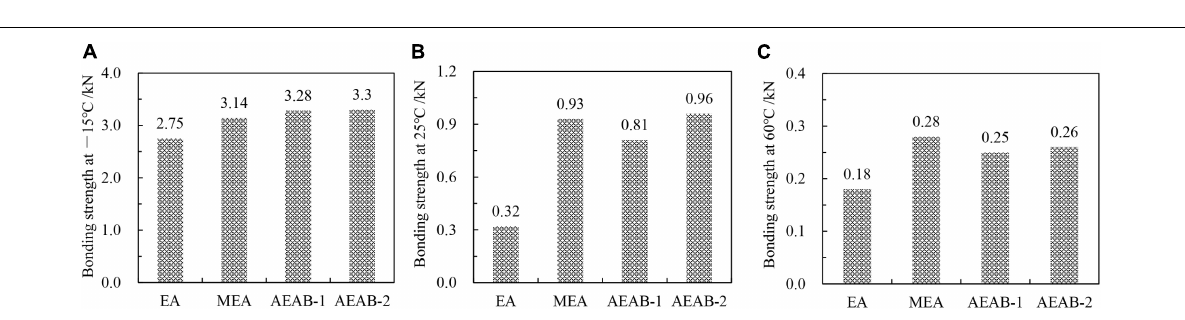
FIGURE 10 | Bonding strength of different coating materials at different temperature: (A) At − 15 ◦ C (B) At 25 ◦ C (C) At 60 ◦ C. In the figures, EA represents the emulsified asphalt binder, and MEA represents the modified emulsified asphalt